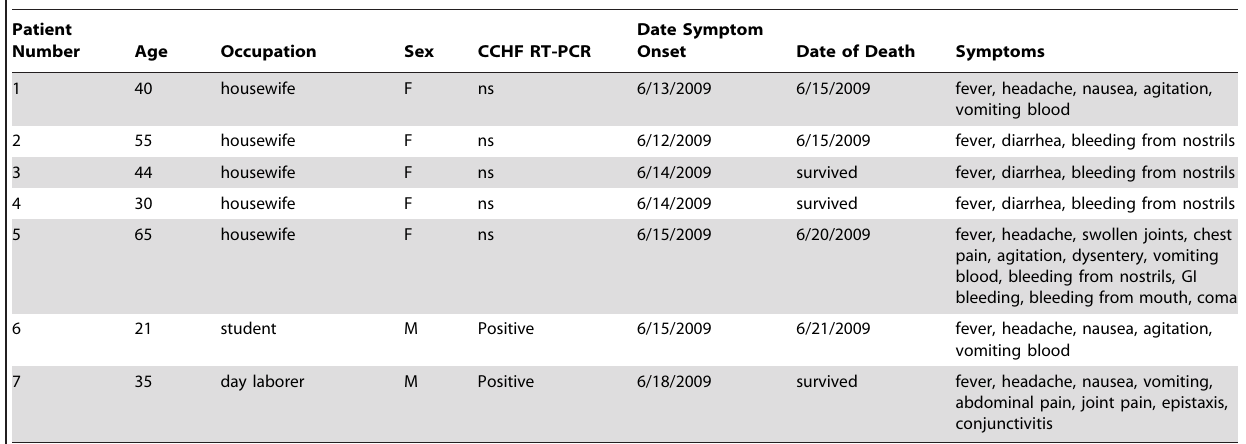
Table 1. Suspect hemorrhagic fever case characteristics.